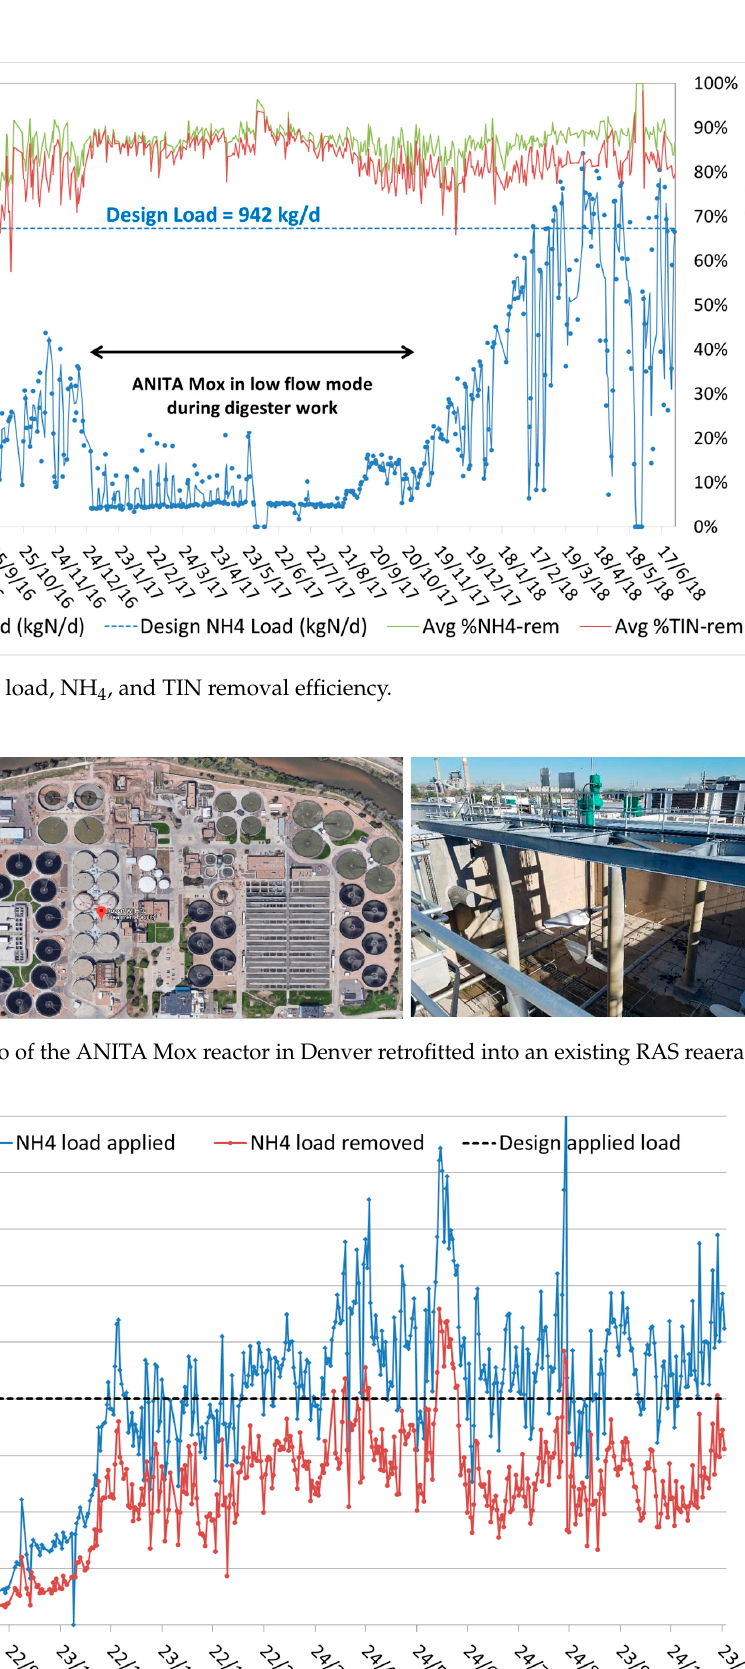
Figure 6. NH 4 load applied and removed (in kgN/d) at Denver since start-up of the ANITA Mox.